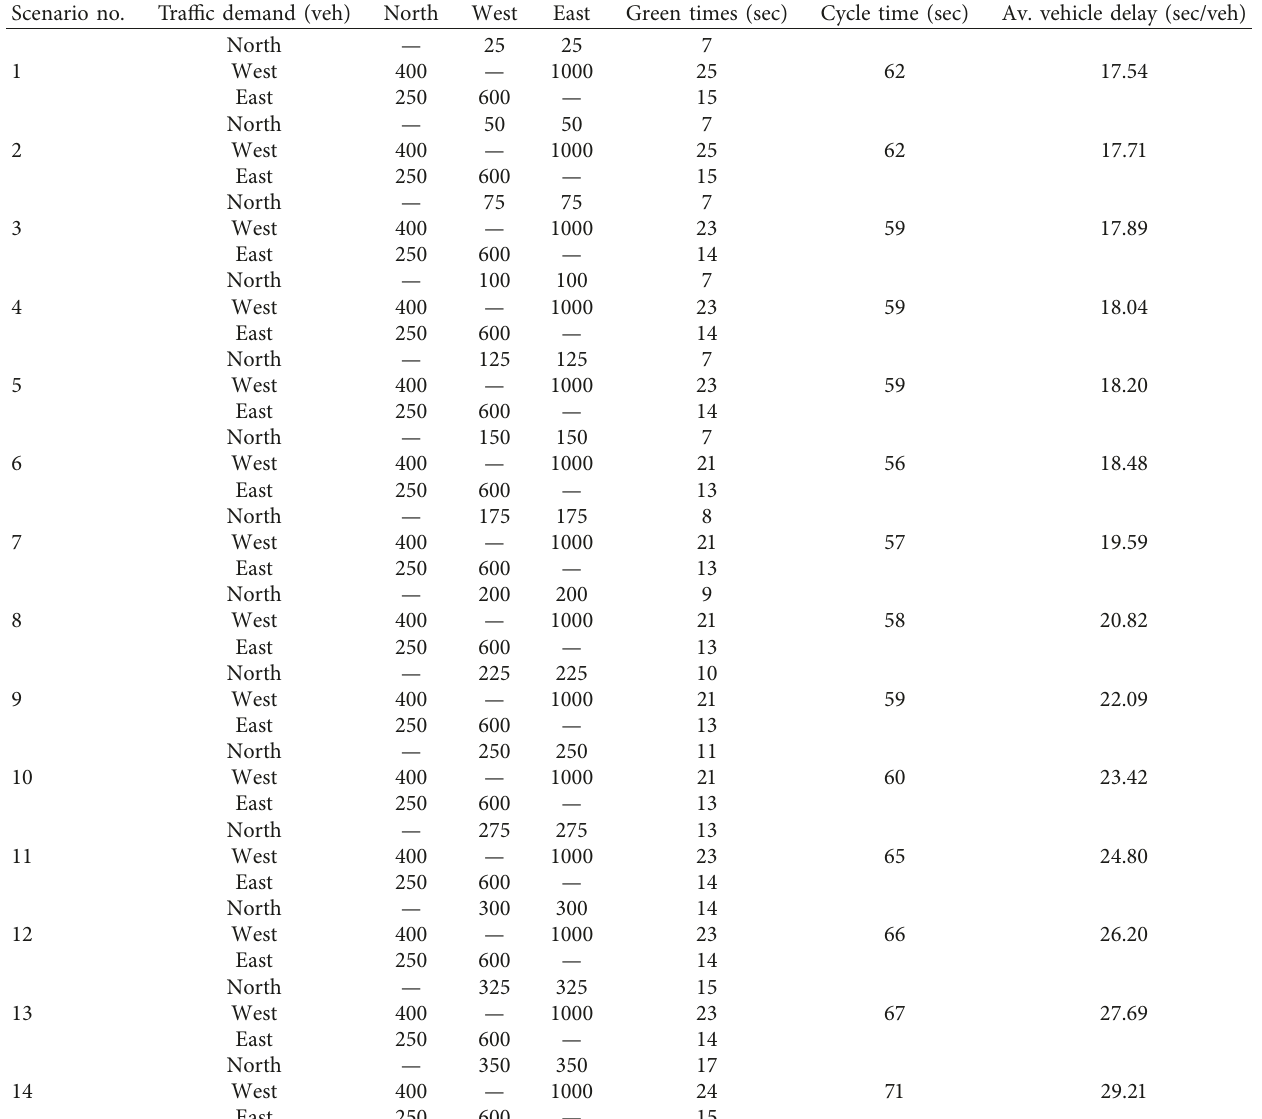
Table 3: Traffic volumes, optimum signal timings, and average vehicle delays for created traffic scenarios. Scenario